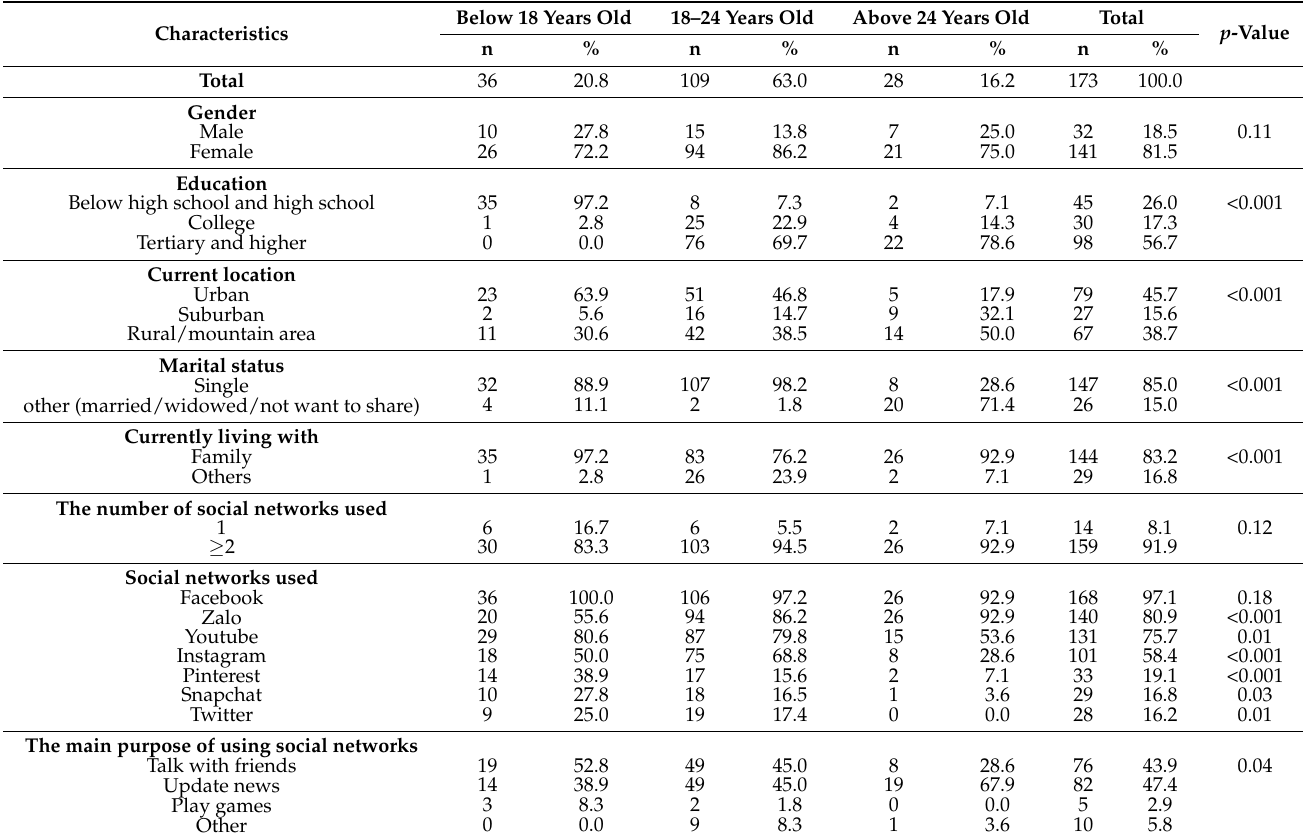
Table 1. Demographic characteristics of participants ( n =